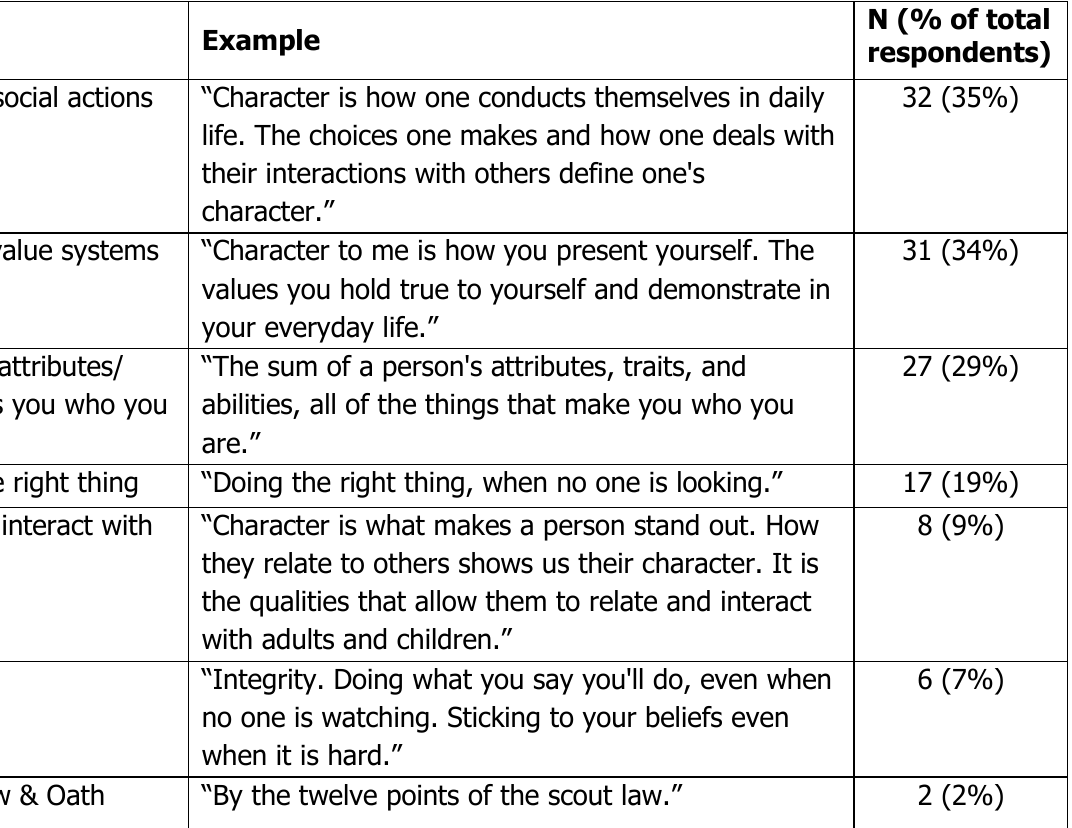
Codes and Examples of Adult Volunteer Open-ended Responses about Character. Leaders Responded to the Prompt: “How do you define